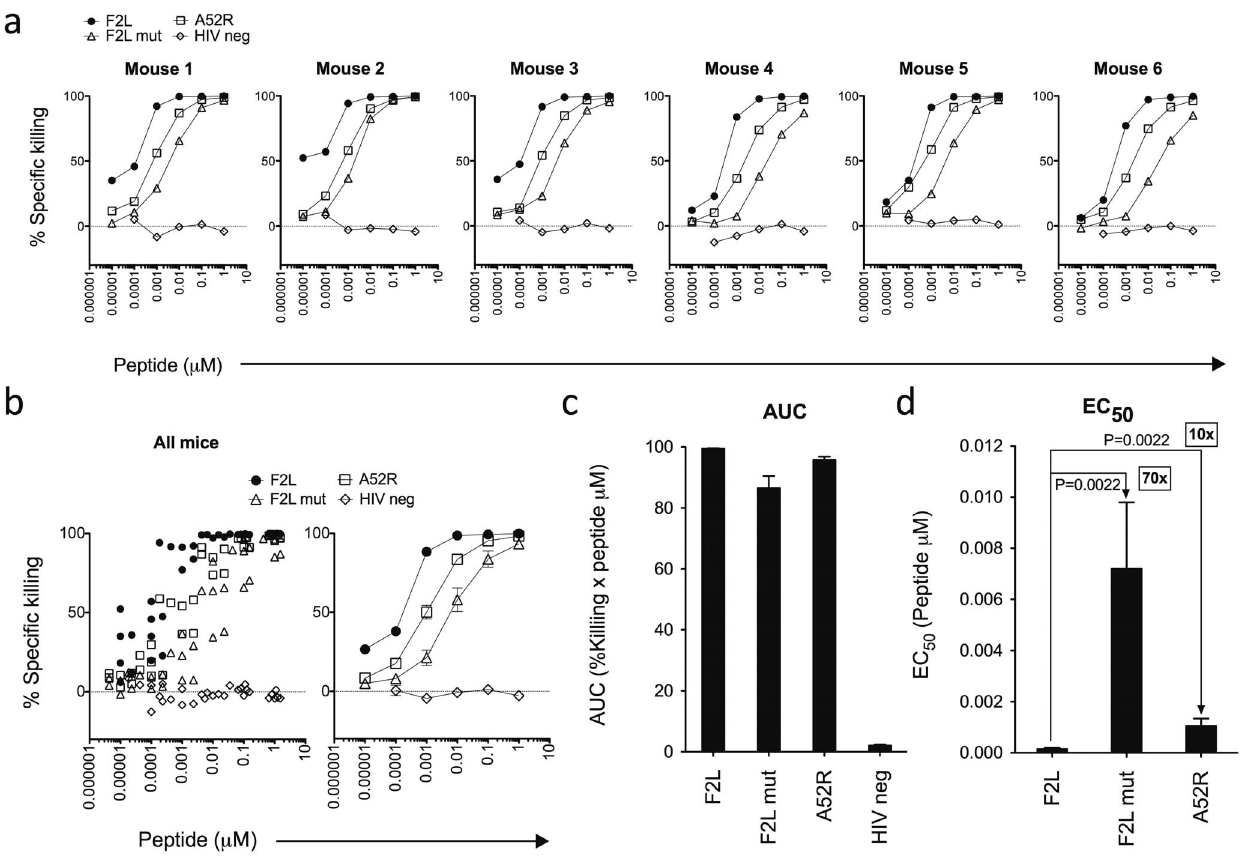
Figure 2. The FTA assay can measure magnitude, functional avidity and epitope variant cross-reactivity of CTL responses invivo . Six BALB/c mice were vaccinated with 5 6 10 6 PFU VV Western Reserve i.p. A FTA was constructed using mouse splenocytes and comprised of fluorescent target cells pulsed with 6 different concentrations of the MHC-I binding peptides F2L, F2L mut, A52R, and HIV neg (as a negative control). FTA target cells were injected i.v. into infected mice 6 days post vaccination and after 18 hr in vivo % specific killing calculated for FTA target cells from harvested spleens. a) In vivo killing responses from six infected animals. b) Summary of responses from all mice with means of % specific killing and standard error of mean. c) Mean area under curve (AUC) measurements from % specific killing response curves and associated standard error of means. d) Mean effective concentration of peptides used to pulse target cells that generated half maximal responses (EC 50 ) and associated standard error of means and P values.